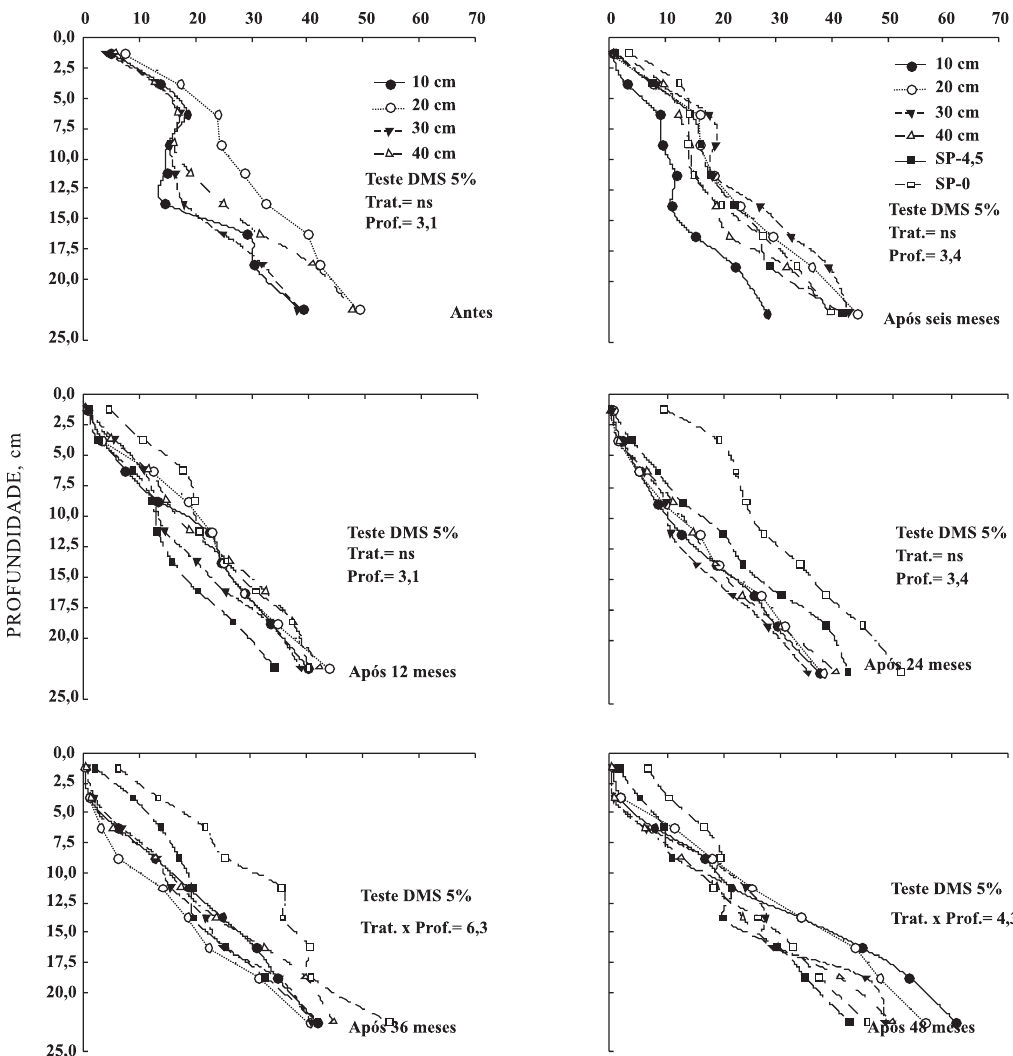
Figura 5. Valores de saturação por alumínio em diferentes épocas da aplicação superficial de calcário em Latossolo Vermelho, sob sistema plantio direto e integração lavoura-pecuária, com diferentes pressões de pastejo no inverno (ns: não